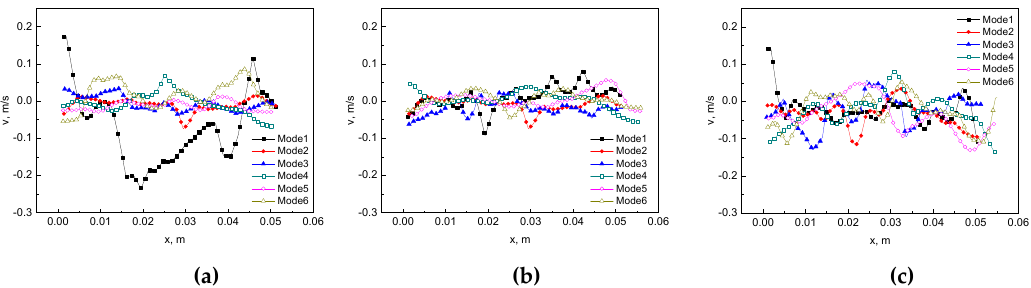
(b) Figure 13. The hydraulic jump height of different laying modes in three hydraulic jump forms. ( a ) 0.8m/min ( b ) 2.4m/min At 0.8 m/min casting speed, the liquid level/height of the hydraulic jump changes as follows: CHJ: the hydraulic jump height/depth of modes 4 and 5 is the lowest and about 9 mm; the maximum height of modes 1, 2, 3, and 6 can reach 15–18 mm.